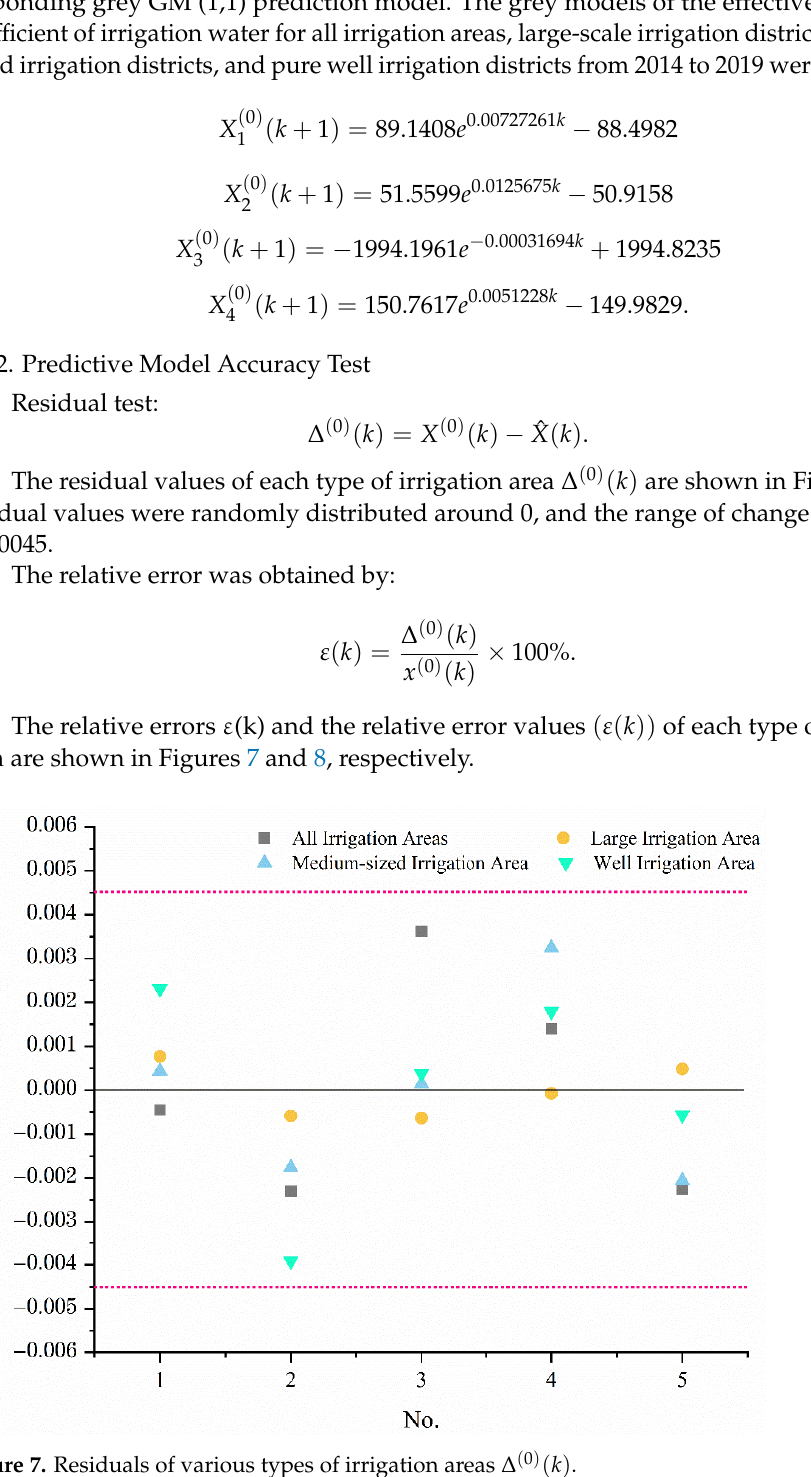
Figure 8. Relative error values (𝜀(𝑘)) of various types of irrigation areas.